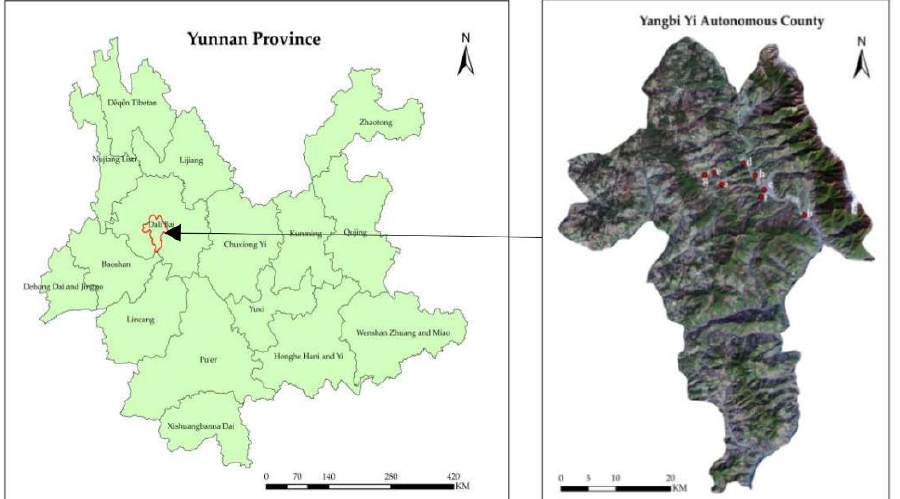
Figure 2. The study area.